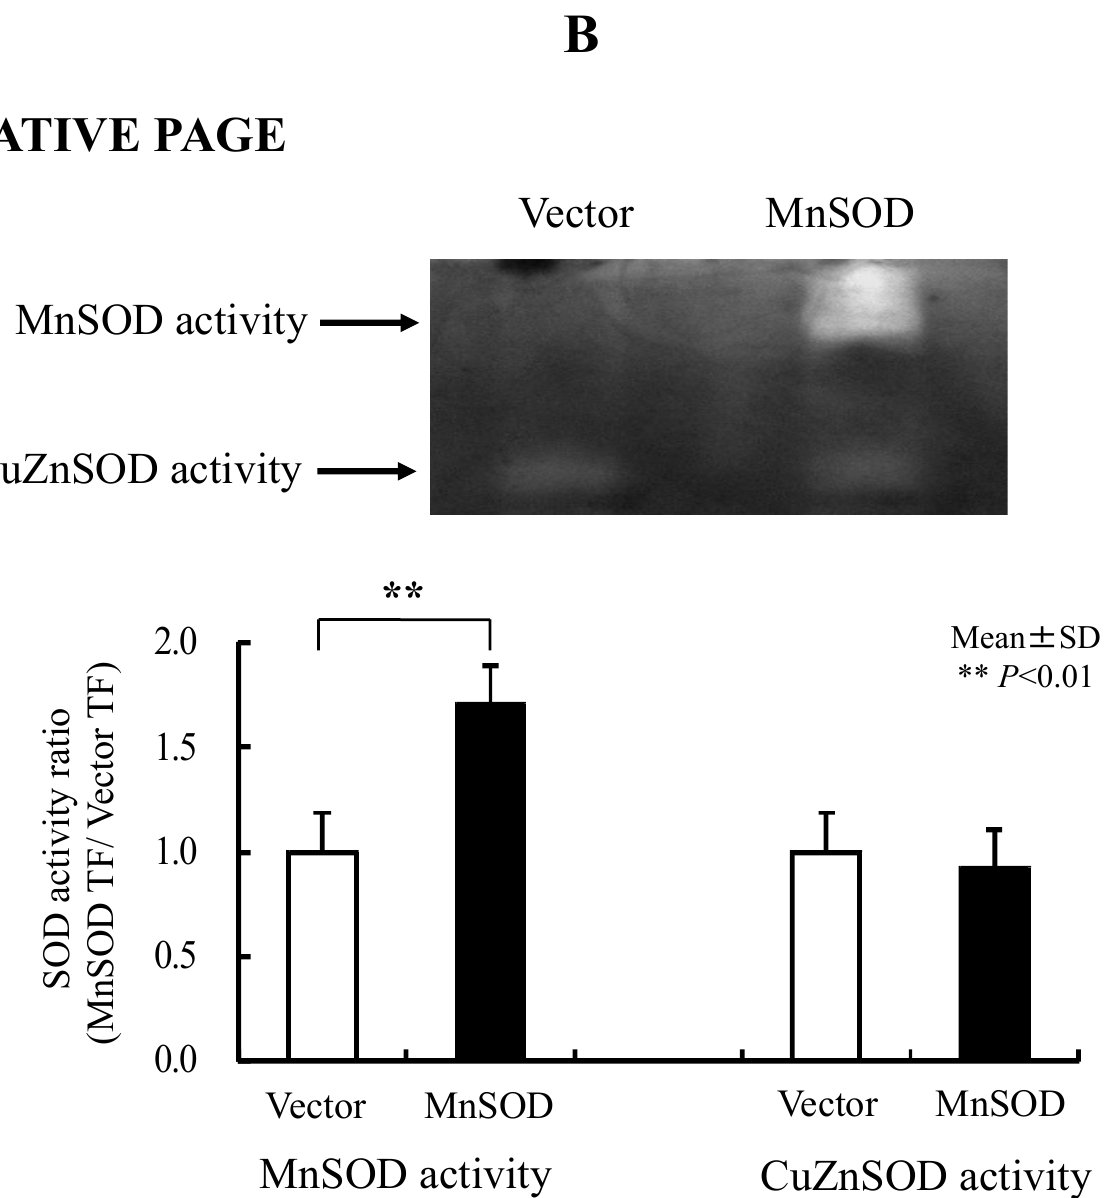
Figure 5. RGK1-MnSOD Gene Expression by hMnSOD cDNA Vector Transfection, and RGK1-